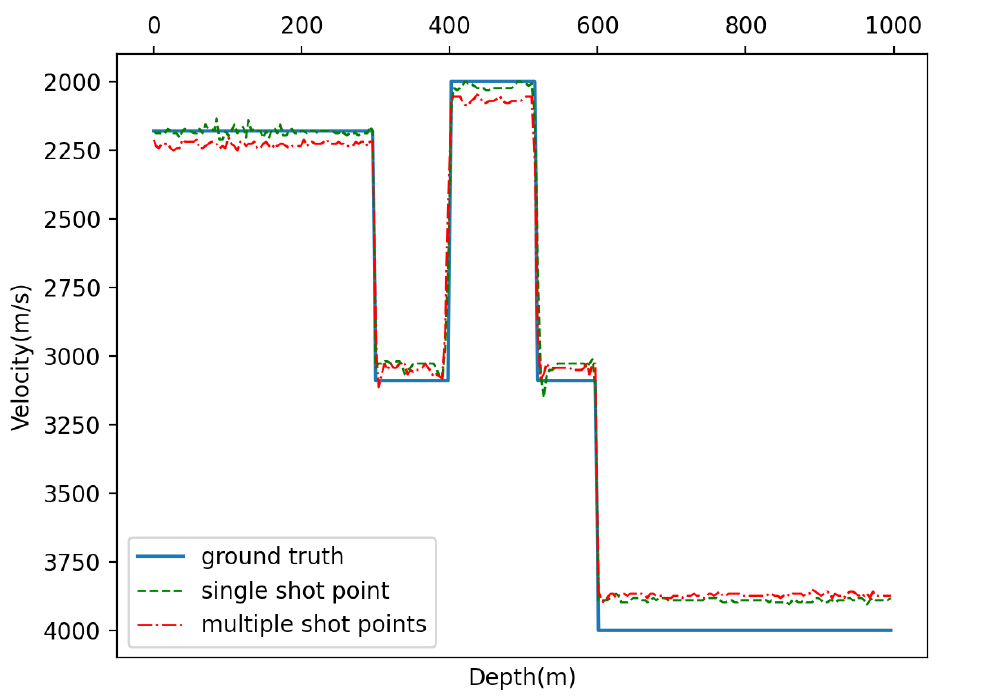
Figure 12. Vertical velocity profiles of velocity field with one anomaly and